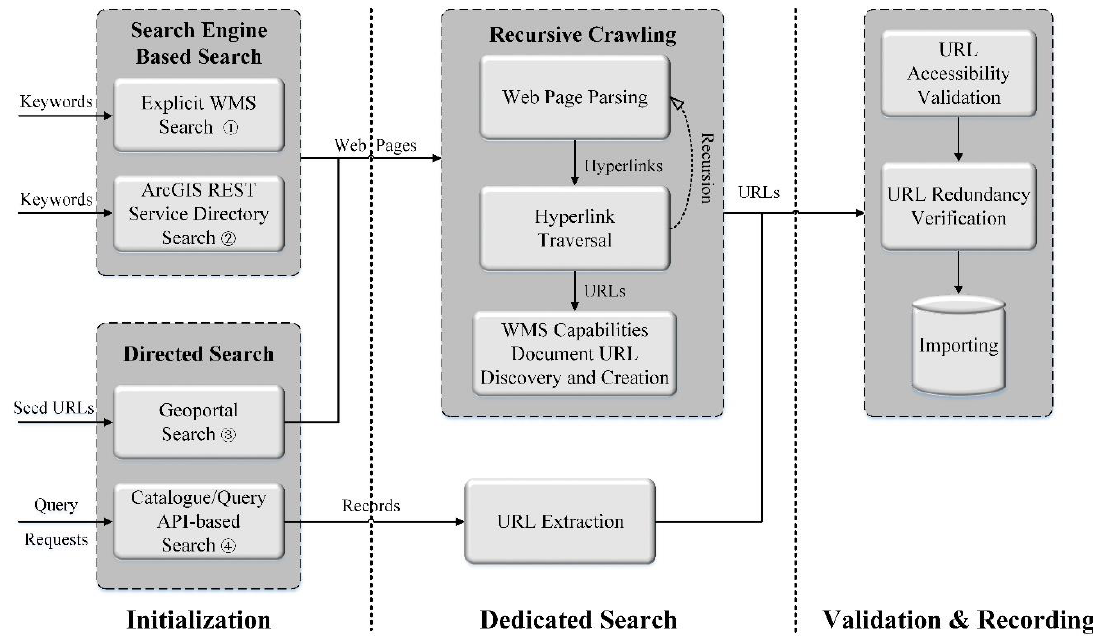
Figure 2. Search strategies and discovery workflow of web map services.